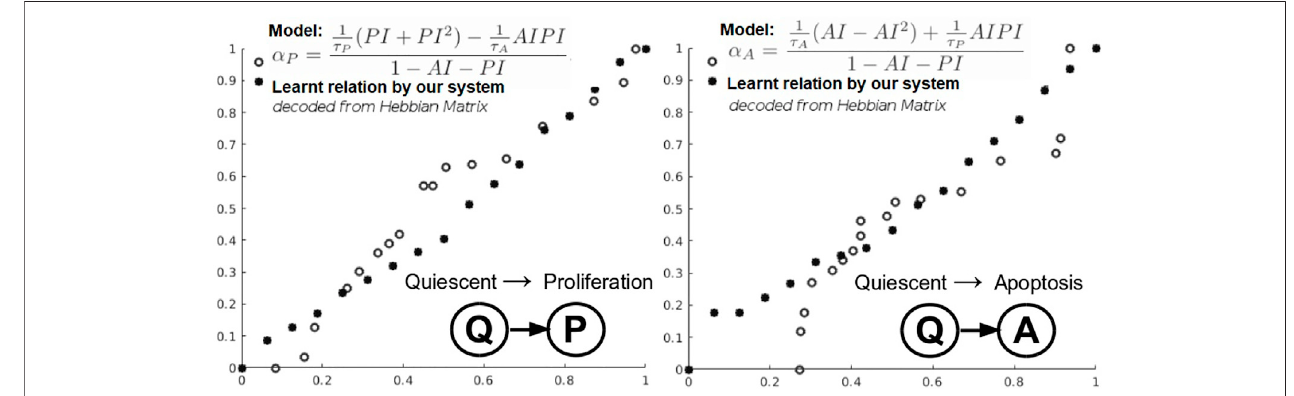
FIGURE 6 | Learning cancer cells phenotypic states transitions mathematical relations.